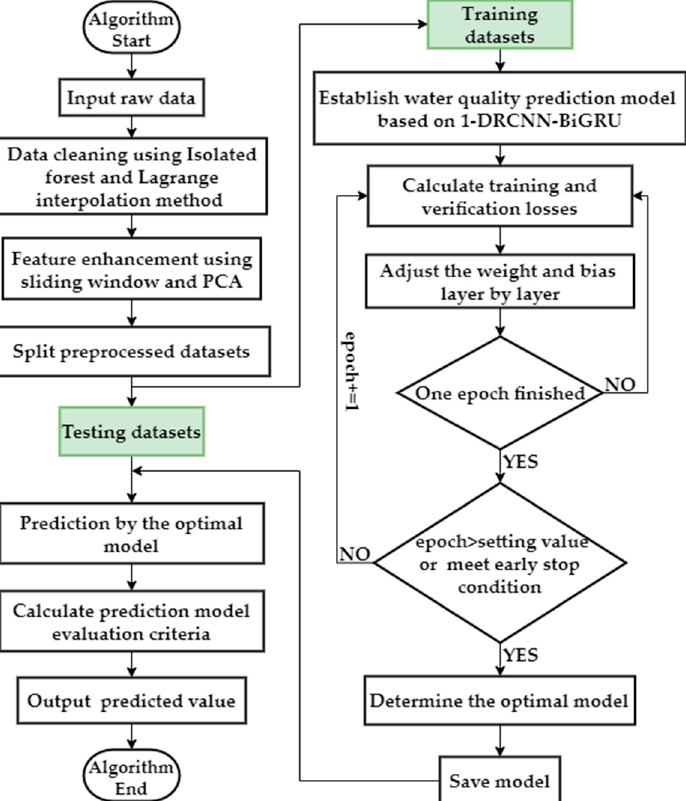
Figure 5. Flow chart of water quality prediction algorithm based on 1-DRCNN and BiGRU.